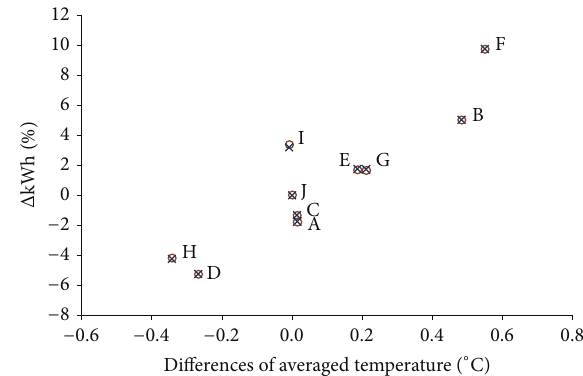
Figure 8: The percentage of Δ kWh versus difference of averaged temperature during July to October